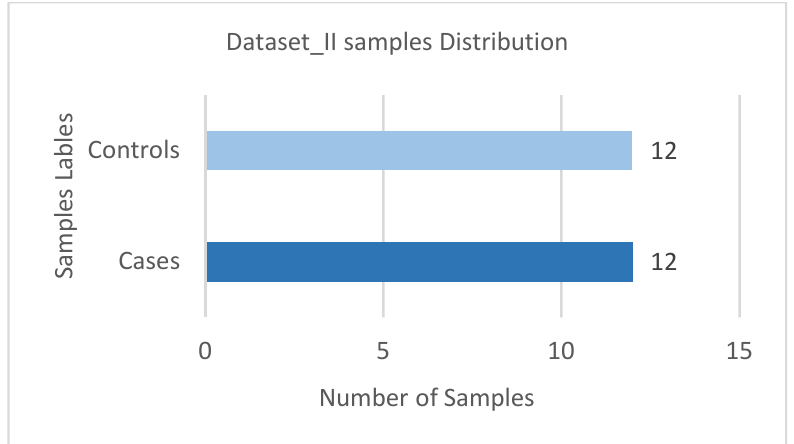
Figure 2. Sample distribution of Dataset_II (MS Disease): (a) 110 samples of MS patients treated by Fingolimod; (b) 105 samples of MS patients before Fingolimod treatment.